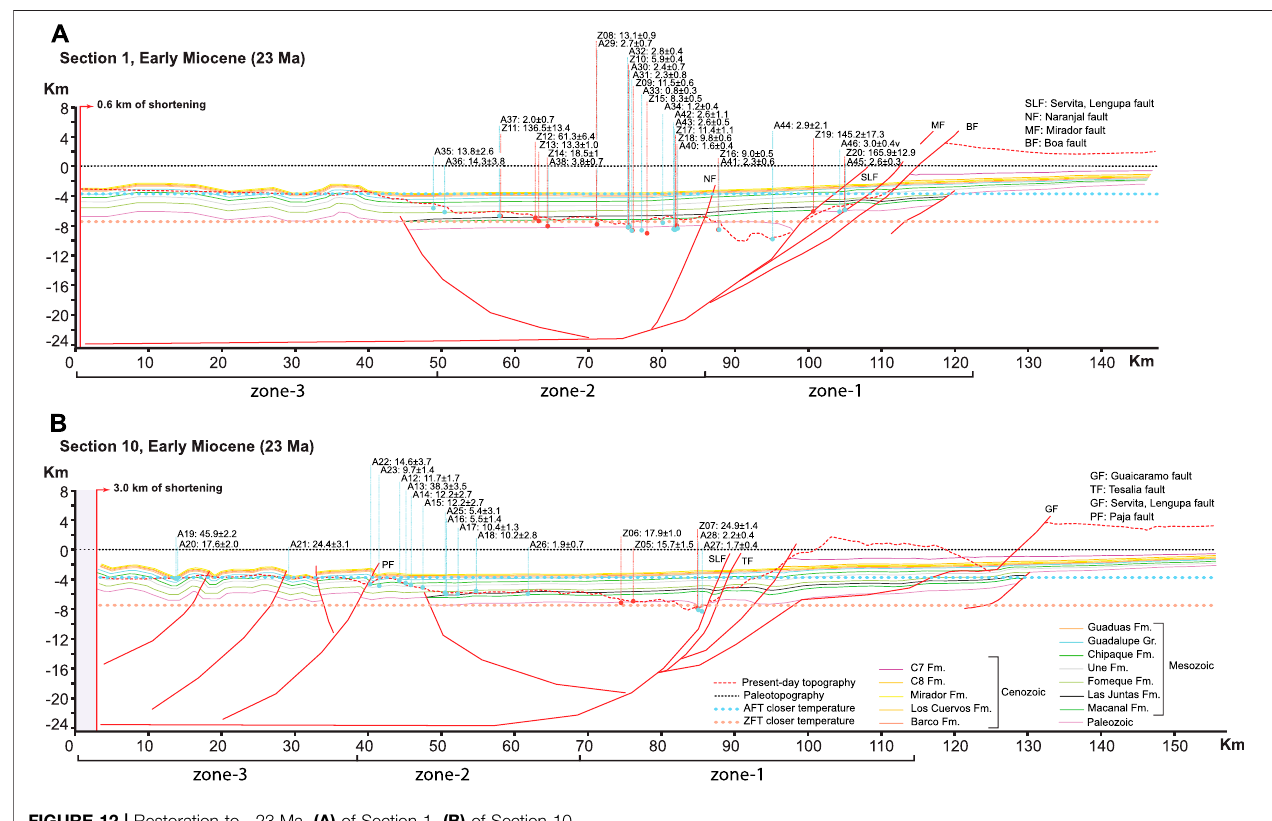
FIGURE 12 | Restoration to ∼ 23 Ma, (A) of Section 1, (B) of Section